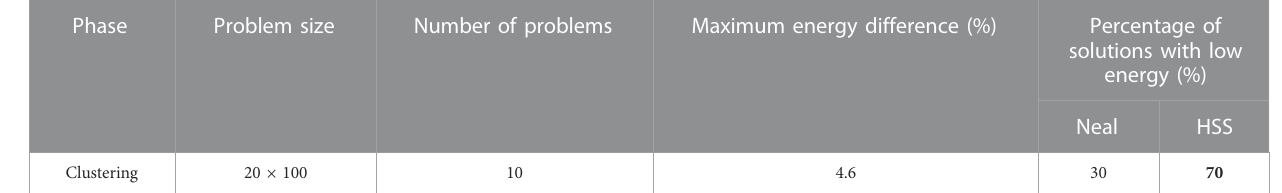
each with SA for all cases, is shown in Table 9. Here, the processing time is calculated by the total processing time of the clustering and routing phases according to Table 6. The percentage of break solutions means the percentage of the total 200 route optimization solutions. In all cases, the changes in each setting